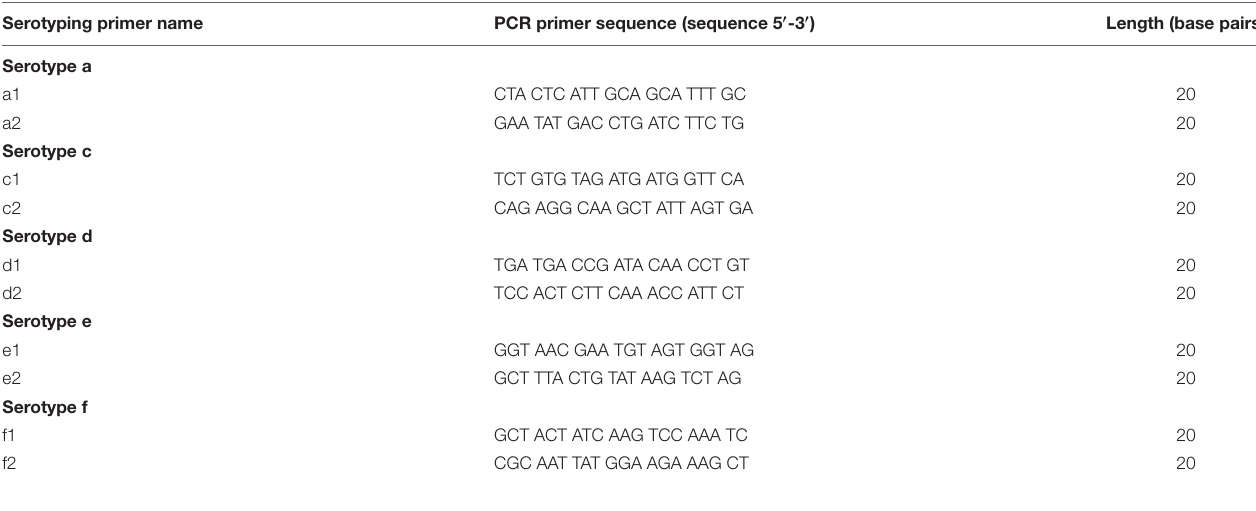
TABLE 2 | (B) PCR Primer sequences in this study ( Falla et al., 1994